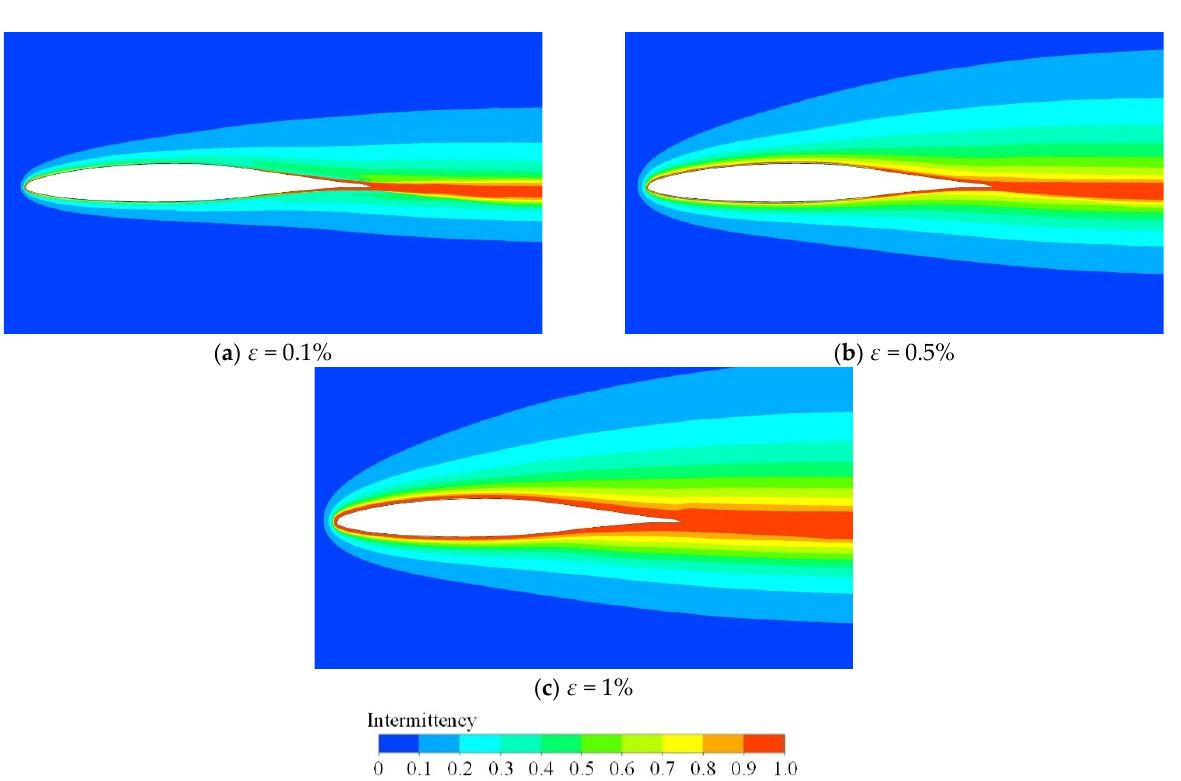
Figure 6. Influence of turbulent intensity on distribution of intermittency ( T w = 293 K, α = 0 ◦ , Ma = 0.4).